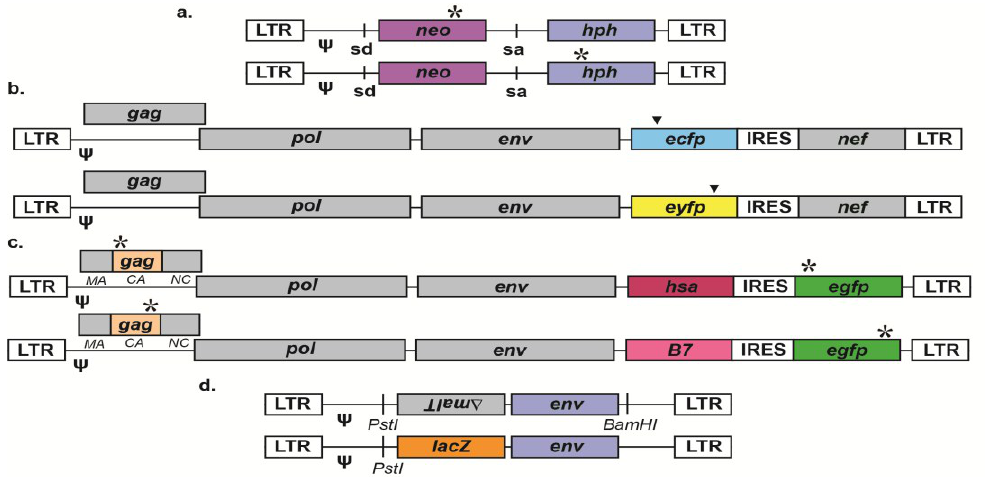
Figure 2. Vector pairs for the investigation of retroviral recombination. Most accessory genes and cis elements are not shown for simplicity; * represents inactivating mutations, while  represents packaging signals. ( a ) SNV vector pair that detects recombination events that restore neo and hph , resulting in viruses that confer G-418 and hygromycin B double drug-resistance to infected cells [43]; sd = splice donor, sa = splice acceptor. ( b ) HIV-1 vector pair that detects recombination events between ecfp and eyfp , which leads to expression of a modified GFP [55]; ▼ = essential mutations in ecfp and eyfp . ( c ) HIV-1 vector pair that can simultaneously detect recombination events that restore the capsid (CA) portion of the Gag polyprotein (by staining with an appropriate antibody) and enhanced green fluorescent protein (EGFP) [71]. Viral infection is monitored with cell surface markers like the mouse heat stable antigen (HSA) and B7; IRES = internal ribosome entry site. ( d ) HIV-1 vector pair that detects recombination events that occur within a region of homology (such as the viral env) inserted between β-galactosidase (lacZ) and a BamHI restriction site